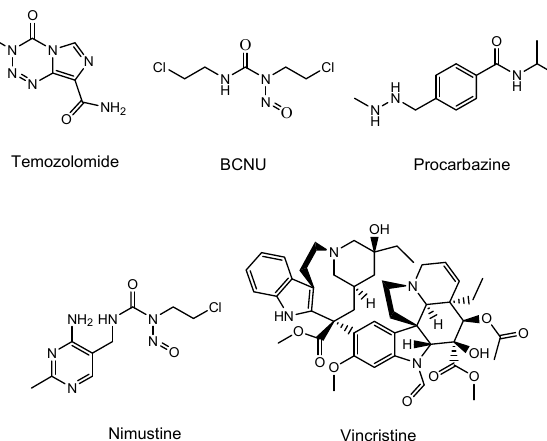
Figure 2. Structures of low-molecular drugs that are used clinically for brain cancers.